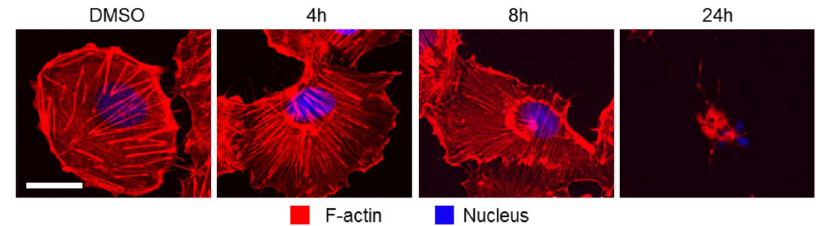
Figure 2. Chondramide leads to reduction of stress fibers and F-actin aggregation. MDA-MB-231 cells were treated with 200 nM ChA or DMSO for indicated time periods, fixed and stained for F-actin and nuclei (n=3). Bar represents 20 m